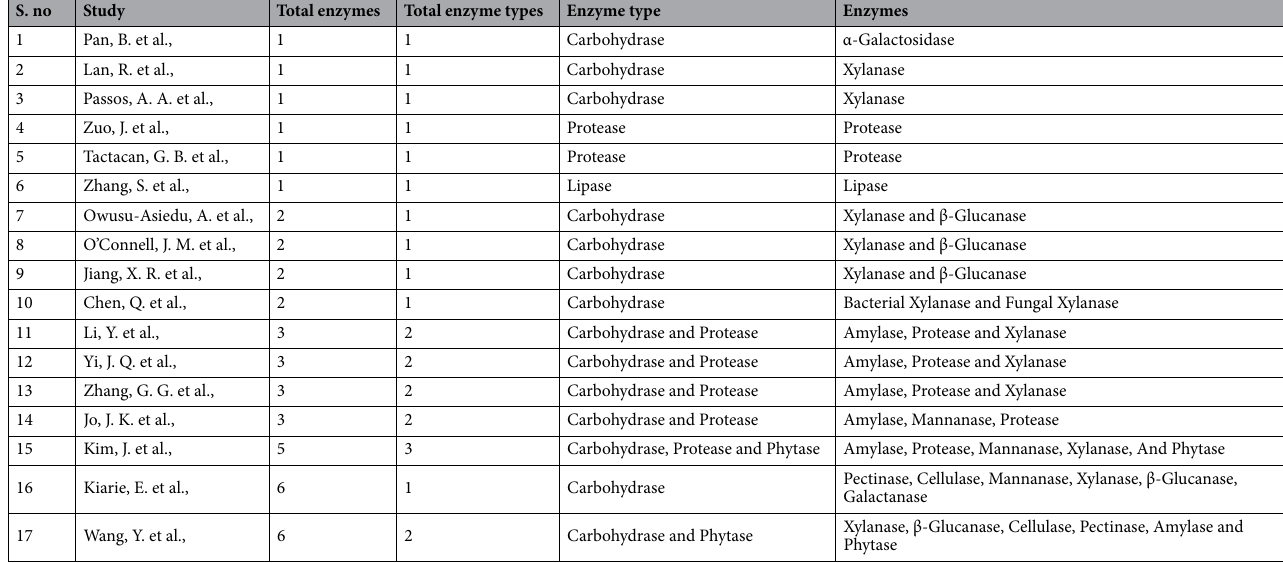
Table 2. Types of enzymes as feed supplement utilized in the meta-analysis. Reference in the table are in the supplementary